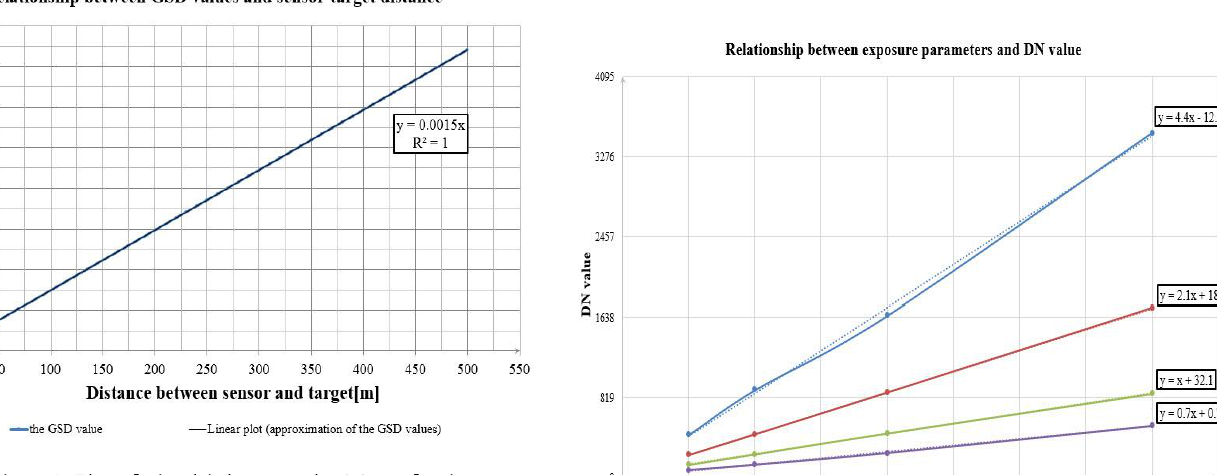
Figure 3. The relationship between the GSD value in a transverse direction to the camera’s flight and the distance to the target